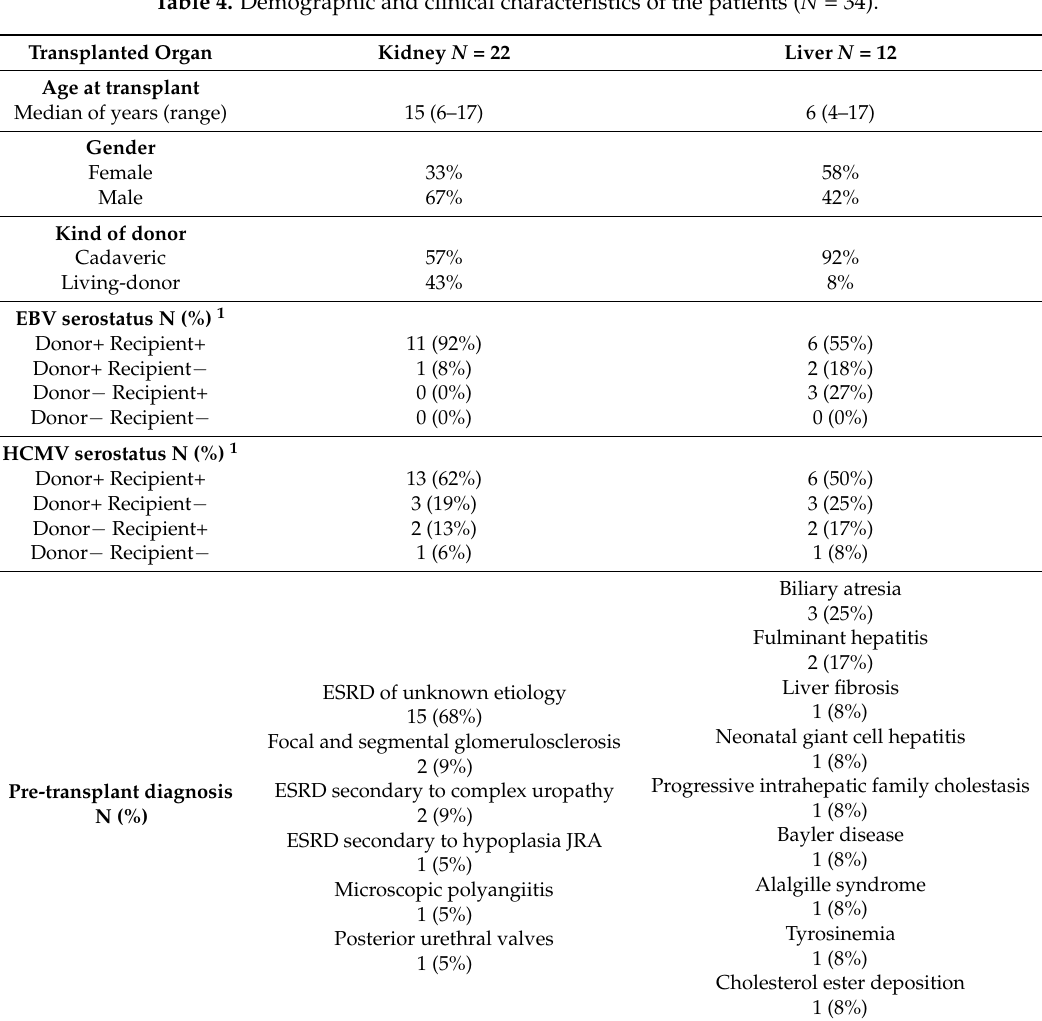
Table 4. Demographic and clinical characteristics of the patients ( N =